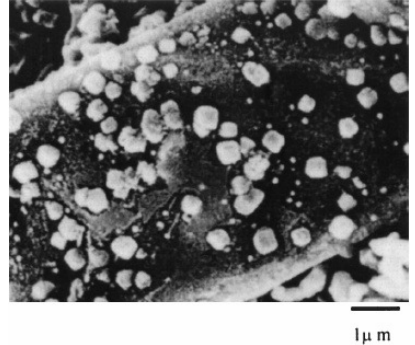
Figure 9. Theoretical scanning electron microscopy of zeolite type-A 8